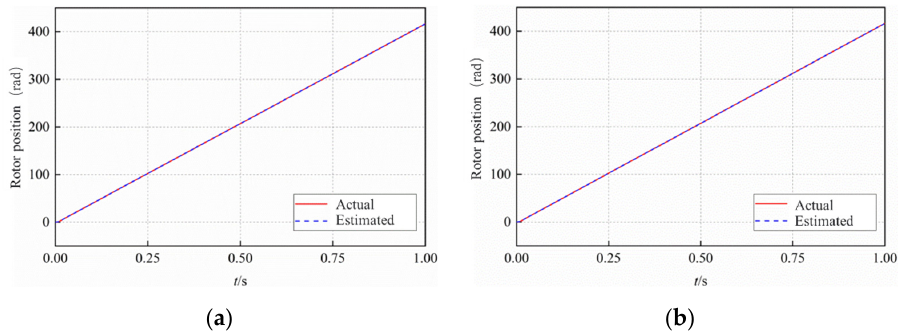
Figure 16. Simulation waveform of rotor position under sudden change of load torque. ( a ) Traditional MRAS algorithm. ( b ) STSM − MRAS algorithm.